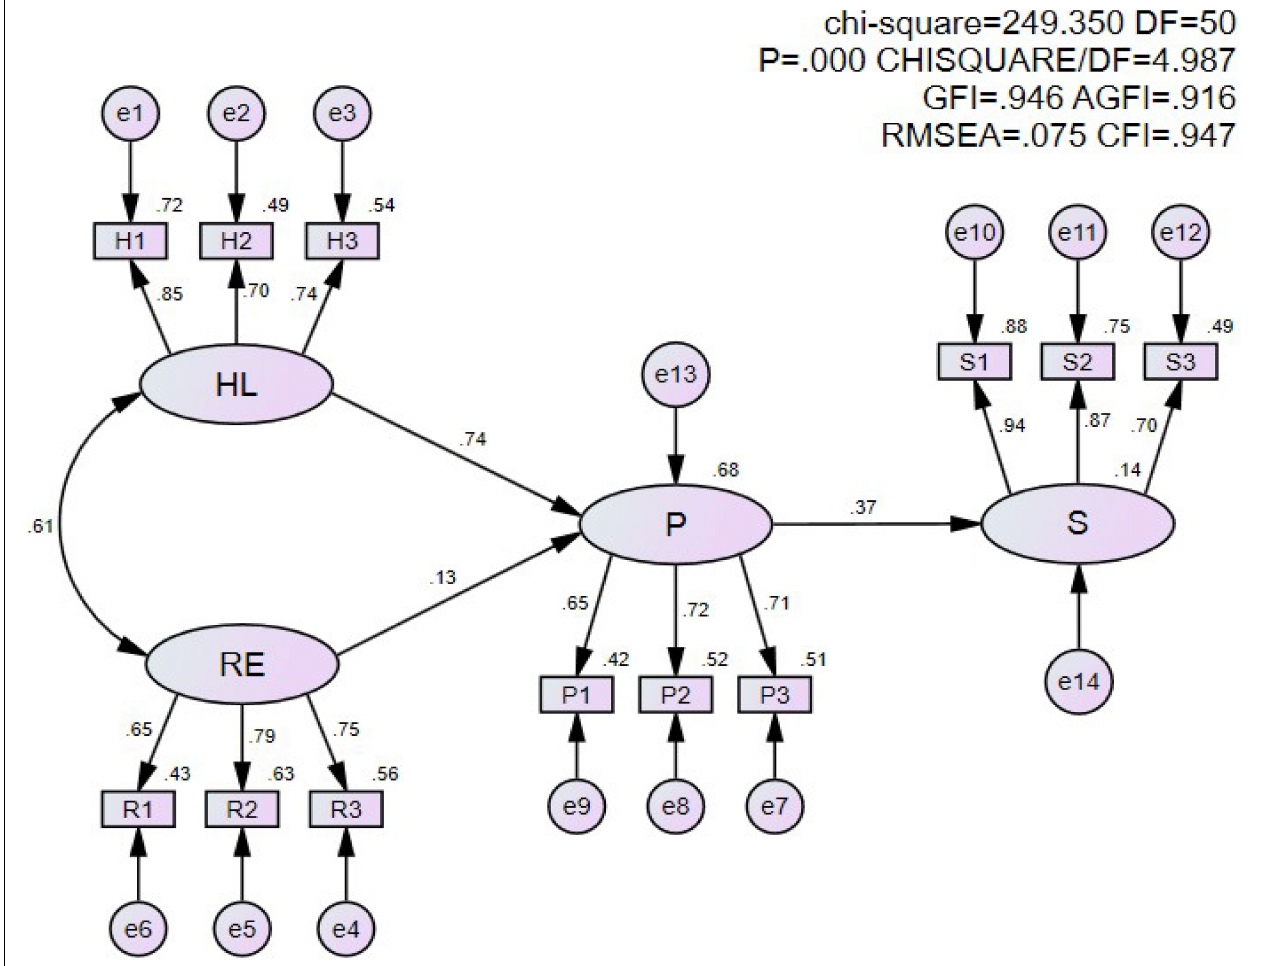
FIGURE 2 | Final structural equation model. In this model, “HL,” “RE,” “P,” and “S” oval boxes are dimension variables; “H,” “R,” “P,” and “S” rectangle boxes are observed variables; “e” boxes are error; The number next to the arrows are parameters in standardized estimates. HL, health literacy; RE, residents’ expectation; P, participation; S,